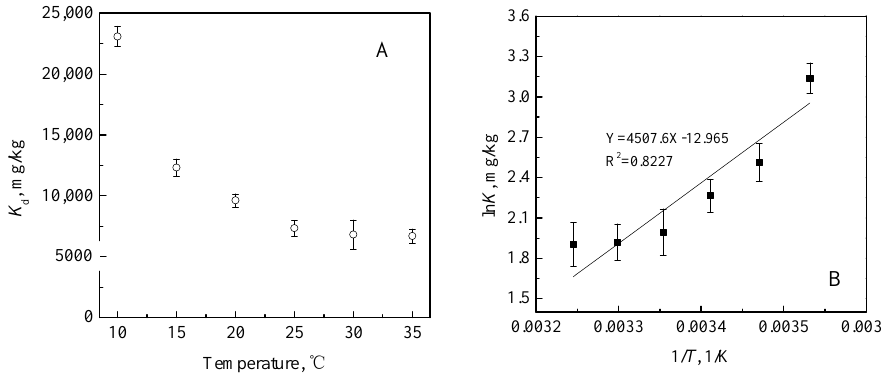
Figure 7. Effects of temperature on the biosorption of phenanthrene onto inactive biomass. ( A ) effects of temperature on partition coefficient; ( B ) relationship between ln K and 1/ T .